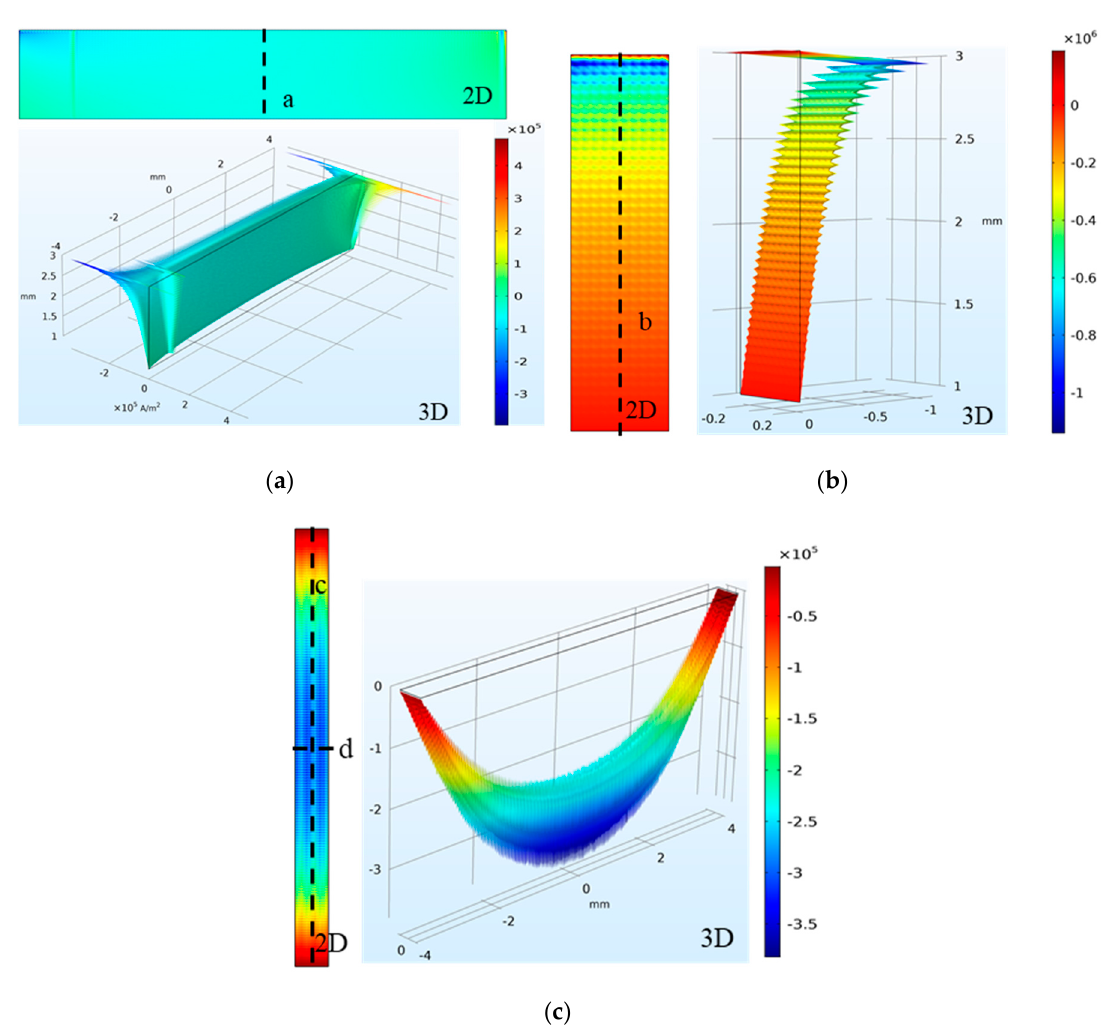
Figure 8. Two-dimensional (2D) and three-dimensional (3D) schematic showing the current density distribution on the ( a ) crack length side, ( b ) crack width side, and ( c ) crack bottom.